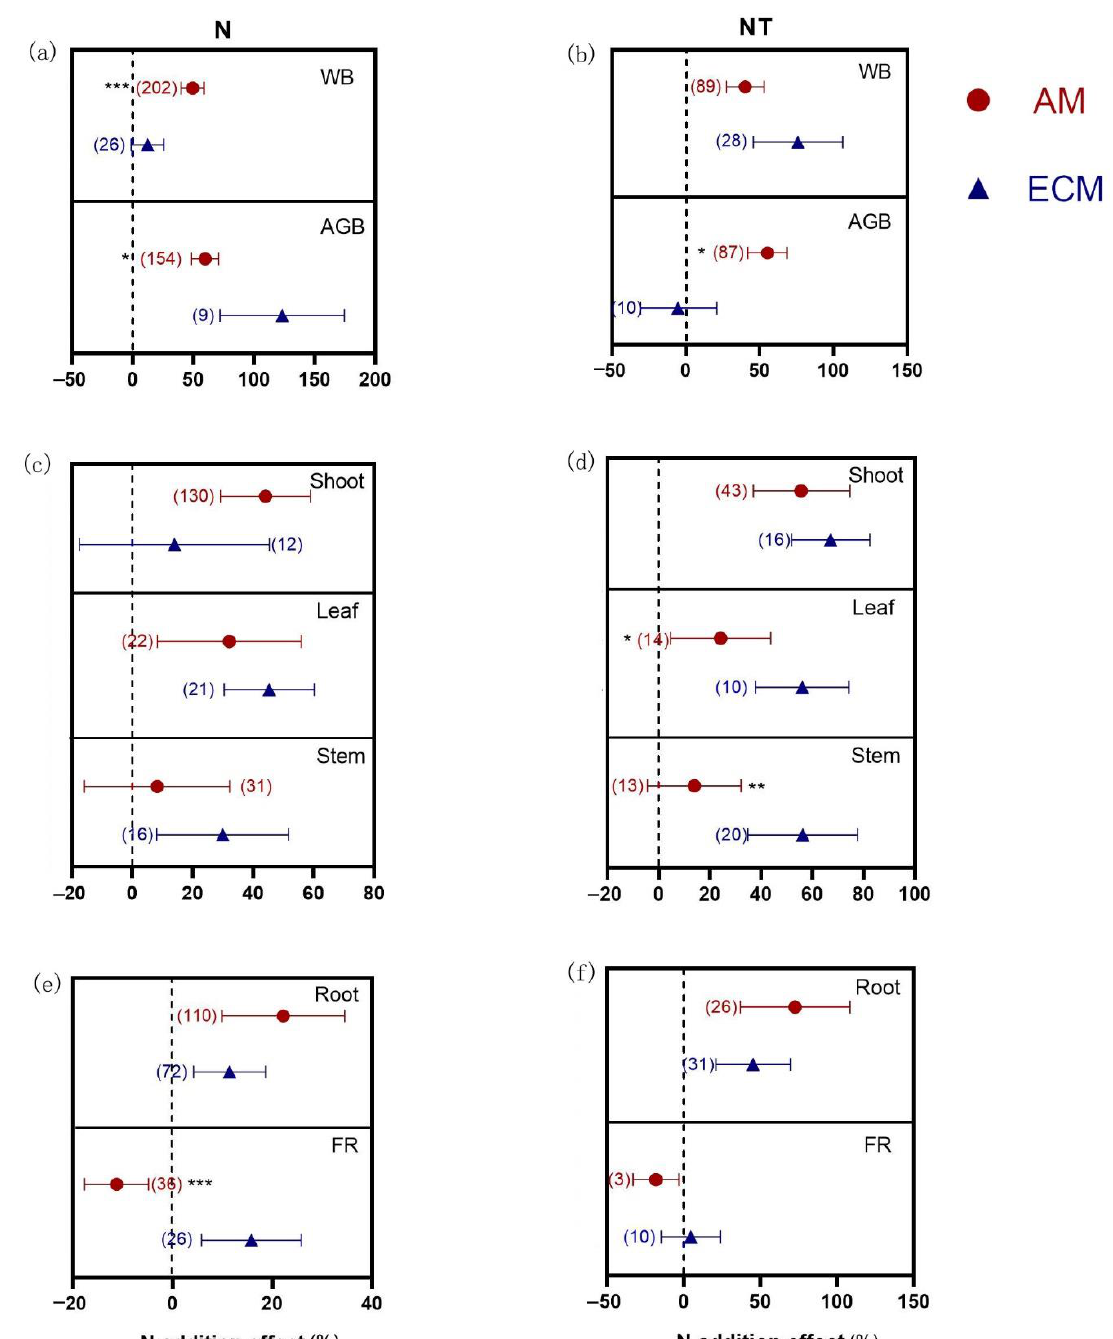
Figure 5. N addition effects on biomass of AM and ECM plants in response to N addition under added N alone ( a , c , e ) and added N together with other treatments ( b , d , f ). AM means arbuscular mycorrhizal type with typical AM structures. ECM means ectomycorrhiza type with typical ECM structures. N means only N addition. NT means N addition with other treatments. The symbols represent the average of the 95% confidence intervals (CIs). The effect is considered to be significant when the 95% CI does not overlap with zero. The chi-square test was used to test the heterogeneity of all index effects between AM and ECM plants (*** p < 0.001, ** p < 0.01, and * p < 0.05). WB, whole plant biomass; AGB, aboveground biomass; FR, fine root. The numbers in parentheses represent the sample size of observations.